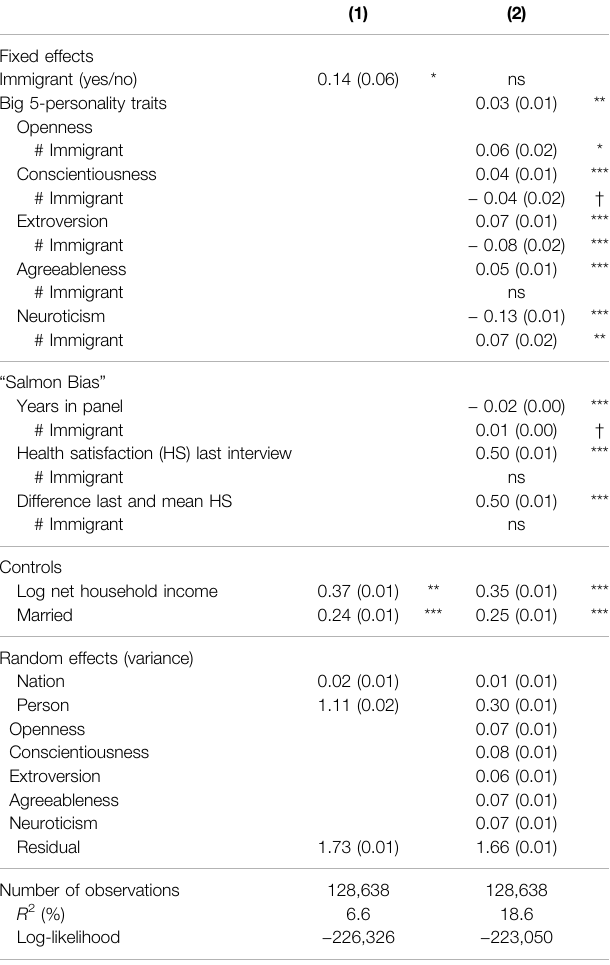
TABLE 2 | Personality selection and